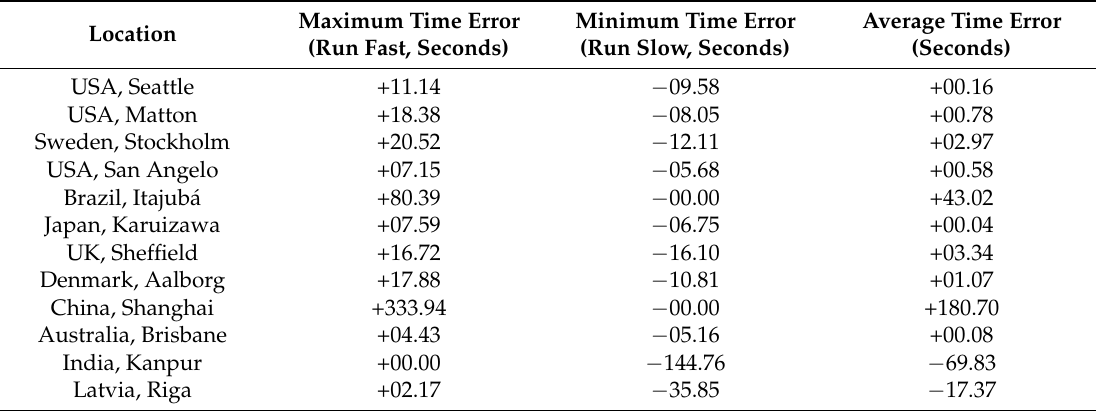
Table 2. Statistical analysis of the monthly time error around the